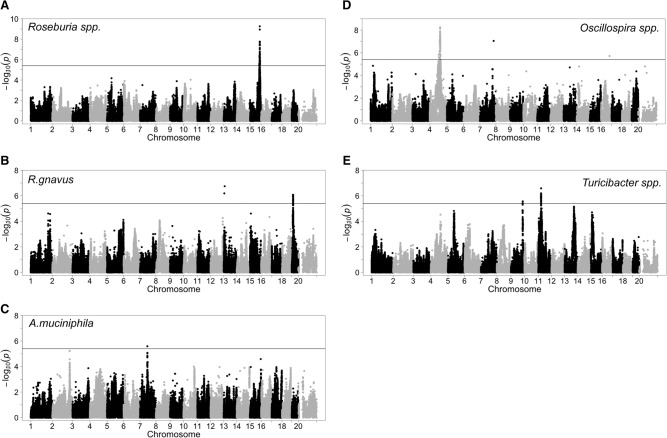
Genome-wide association mapping of gut microbiota genera in the HMDP: (A) Roseburia spp., (B) R. gnavus, (C) A. muciniphila, (D) Oscillospira spp., (E) Turicibacter spp. Association was performed using the FaST-LMM algorithm (Lippert et al. 2011) following correction for population structure using ∼200,000 filtered SNPs genotyped in all strains. The horizontal line indicates the threshold for genome-wide significance (P < 4 × 10−6). See also Supplemental Table 6.